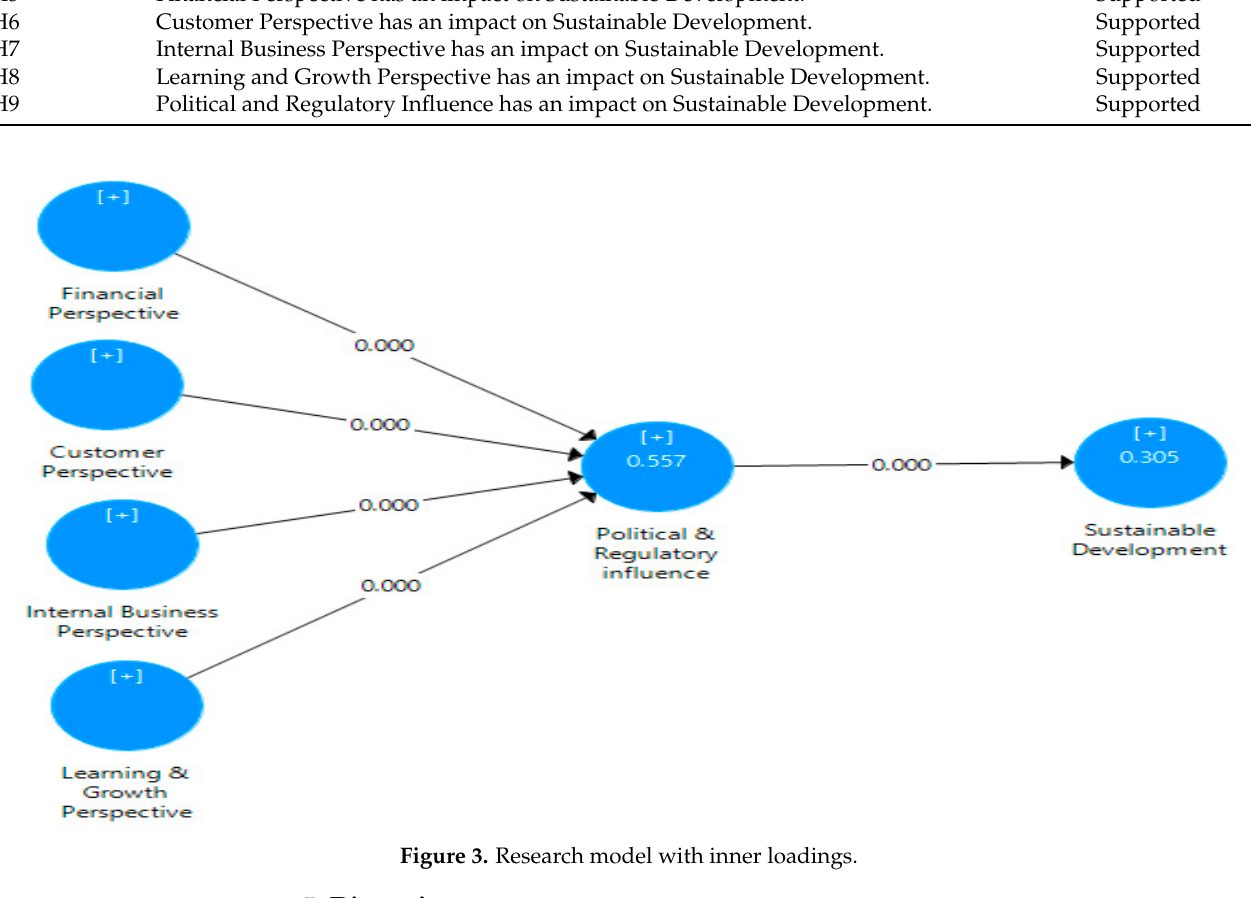
Figure 3. research model with inner loadings. Figure 3. Research model with inner